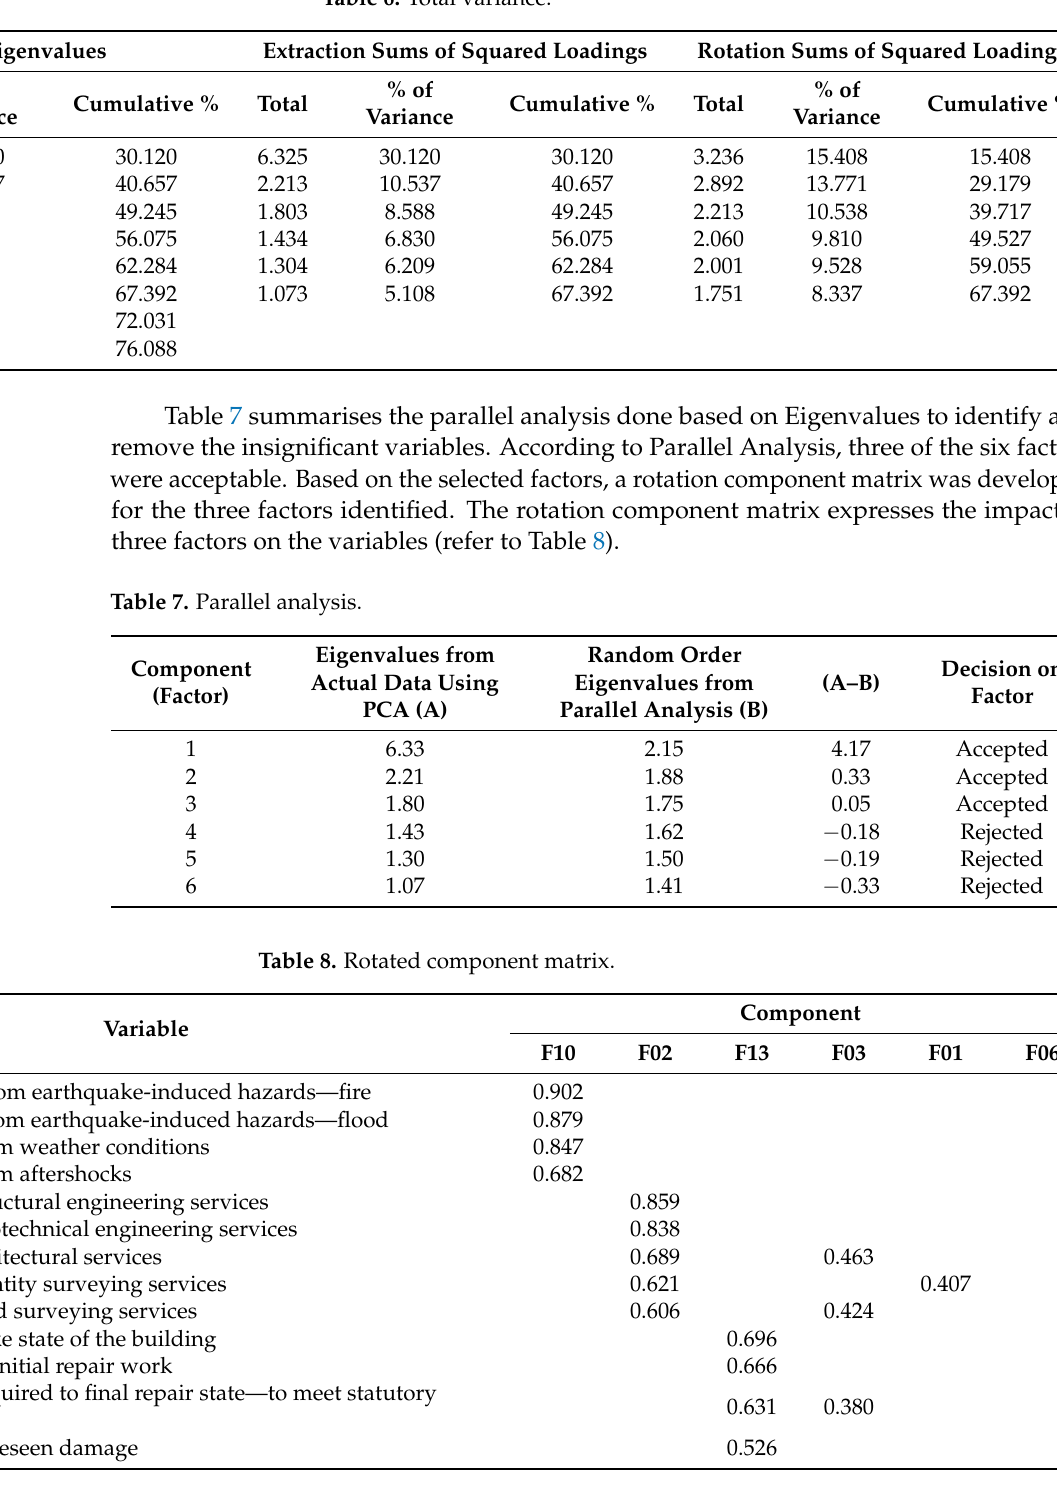
Table 6. Total variance.